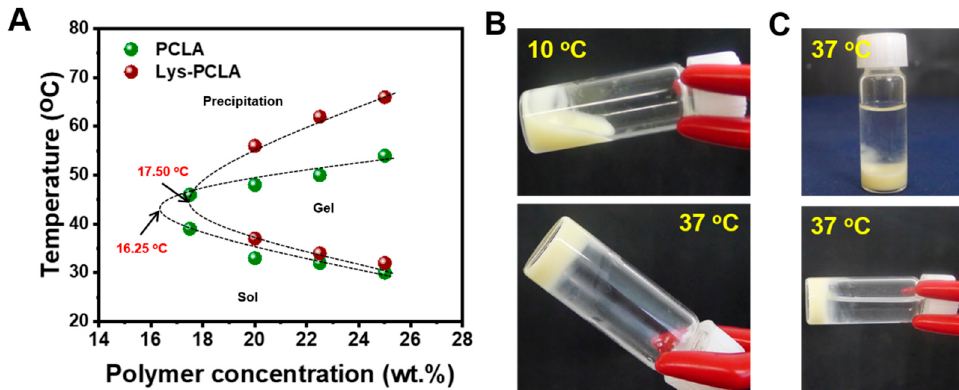
Figure 3. ( A ) Sol-to-gel phase transition of copolymer at varying copolymer concentrations in PBS as a function of temperature. ( B ) Sol-to-gel photographs of 22.5 wt.% Lys-PCLA conjugate at low (10 °C) and physiological temperature (37 °C). ( C ) Stability of Lys-PCLA hydrogels in PBS at 37 °C.